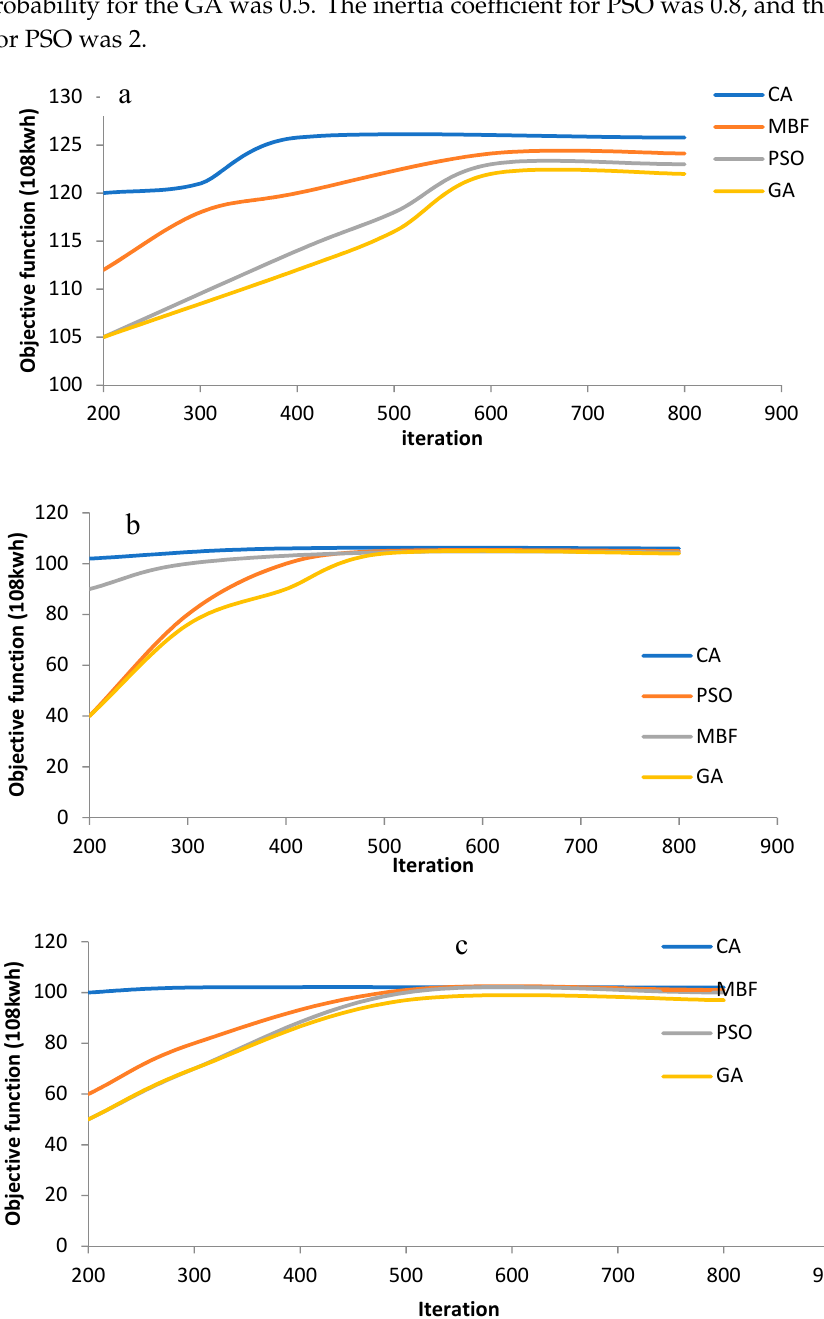
Figure 4. The convergence curve for ( a ) wet years, ( b ) normal years, and ( c ) dry years.